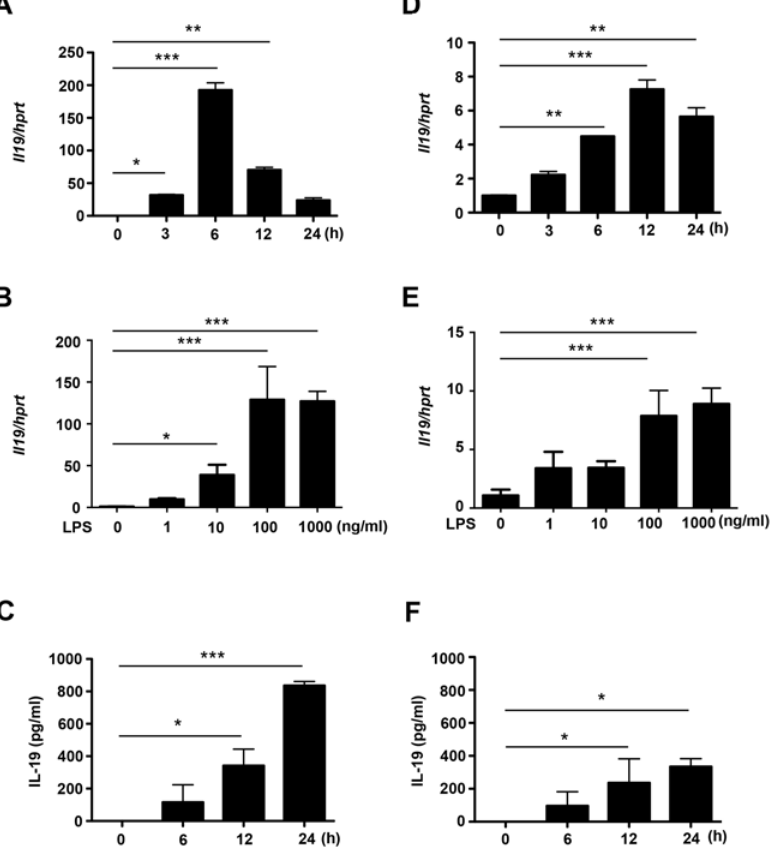
Fig 1. Activated microglia are the predominant source of IL-19 in the CNS. (A) qPCR data for IL-19 in microglia treated with LPS (100 ng/ml) for 0 – 24 h. (B) qPCR data for IL-19 in microglia treated with LPS (0 – 1000 ng/ml) for 6 h. (C) ELISA data for IL-19 in culture supernatant of microglia treated with LPS (100 ng/ml) for 24 h. (D) qPCR data for IL-19 in astrocytes treated with LPS (100 ng/ml) for 0 – 24 h. (E) qPCR data for IL- 19 in astrocytes treated with LPS (0 – 1000 ng/ml) for 12 h. (F) ELISA data for IL-19 in culture supernatant of astrocytes treated with LPS (100 ng/ml) for 24 h. Microglia released approximately twice as much IL-19 as astrocytes. * , p < 0.05. ** , p < 0.01. *** , p < 0.001. Values are means ± SD (n =